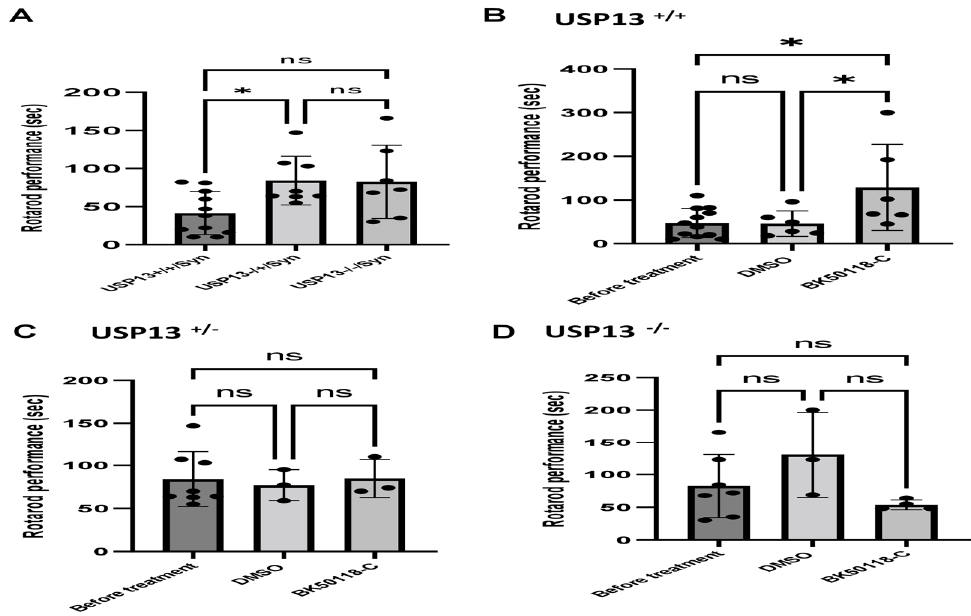
Figure 2. Rotarod behavior test in mice. Rotarod test showed that lentiviral expression of human alpha-synuclein induced motor and behavioral symptoms in wild-type (USP +/+ ) but not in partially (USP +/ − ) or completely (USP13 − / − ) mice ( A ). BK50118-C improves motor and behavioral symptoms in wild-type USP +/+ ( B ), but not in USP +/ − ( C ), or USP13 − / − ( D ) mice. The asterisk indicates statistically significant difference. One-way ANOVA. * p < 0.05. n = 3–12. Mean ± SD. The black dot ● represents each individual data.